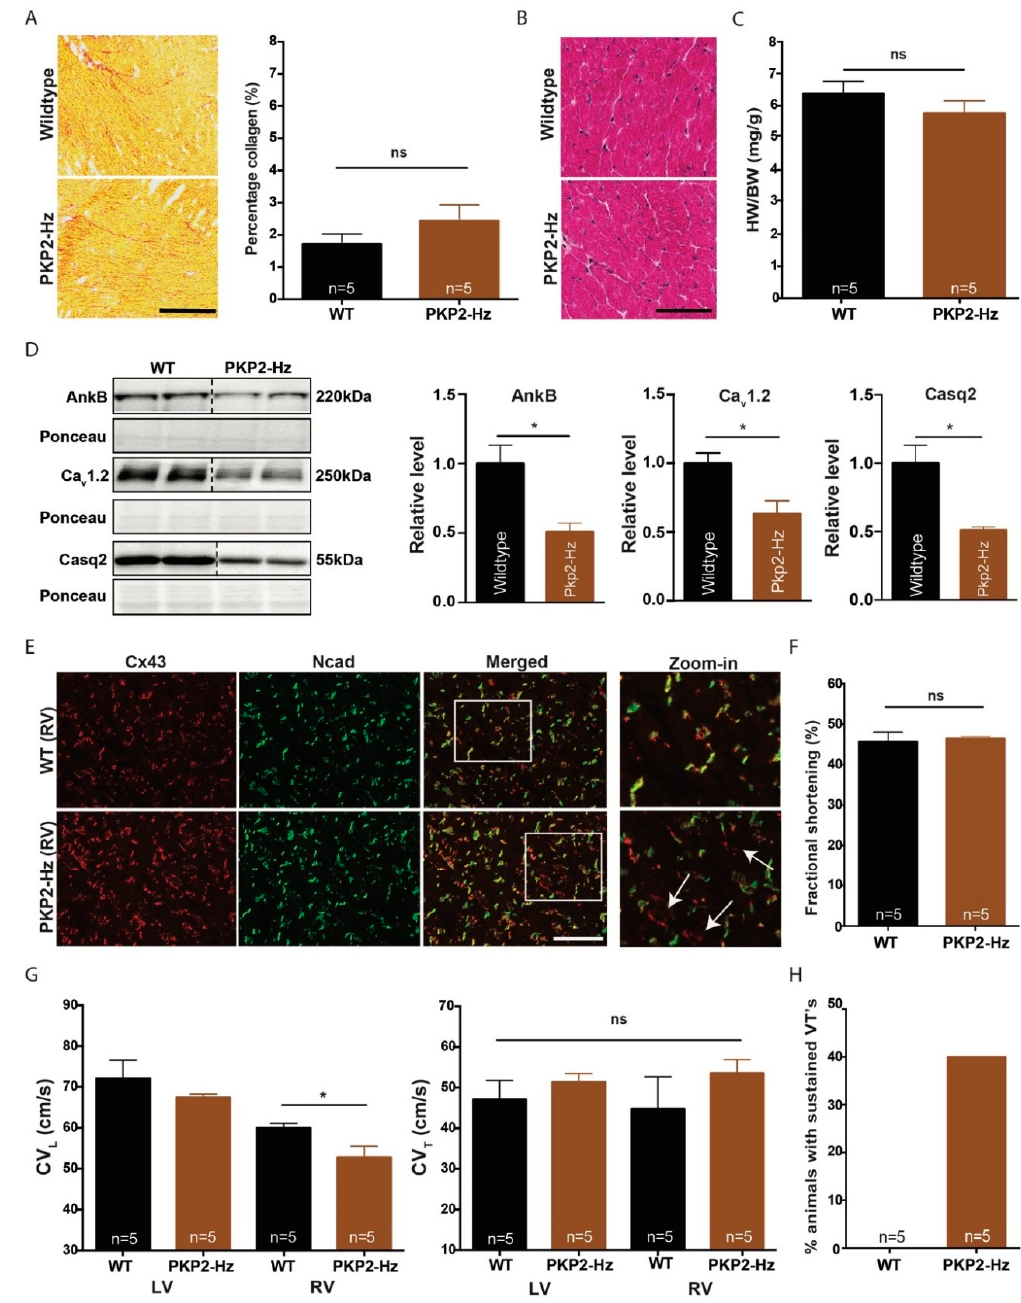
Figure 3. Pro-arrhythmic cardiac remodeling in PKP2-Hz mice exposed to exercise training. ( A ) Representative pictures of Picrosirius red staining (left panel) in the inner myocardium of wildtype and PKP2-Hz murine heart sections, of mice exposed to exercise training; scale bar, 500 µm. Quantification of collagen abundance (right panel) in overview slides of whole heart sections (WT; n = 5 and PKP2-Hz; n = 5, mean ± SEM). ( B ) Hematoxylin and eosin staining of wildtype and PKP2-Hz heart sections, of mice exposed to exercise; scale bar, 100 µm. ( C ) Quantification of heart weight (HW) to body weight (BW) ratio in both groups (WT; n = 5 and PKP2-Hz; n = 5, mean ± SEM). ( D ) Representative western blots (left panel) and average densitometry (right panels, n = 5 for all groups) of AnkyrinB (ANKB), Ca v 1.2, and calsequestrin-2 (Casq2) measured from wildtype (WT) and PKP2-Hz ventricular lysates of mice exposed to exercise training. Left upper panels represent western blots, bottom panels according ponceau staining used for quantification (mean ± SEM, * p < 0.05). ( E )